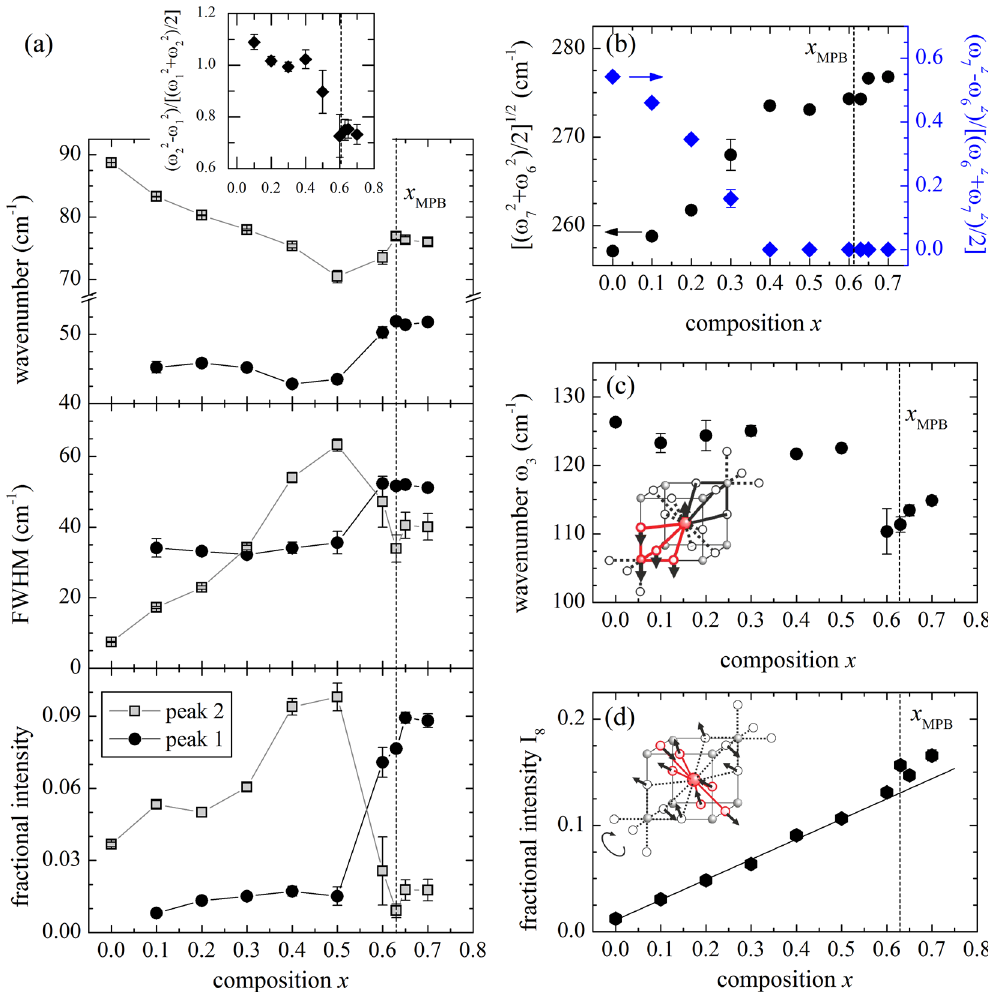
Figure 6. Composition dependence of ( a ) the phonon modes dominated by A-site cationic vibrations (peaks 1 and 2), ( b ) the average squared wavenumber and splitting of phonon modes dominated by B-site cationic vibrations (peaks 6 and 7), ( c ) the wavenumber of peak 3 generated by BO 3 vibrations against A-site cation vibrations (the inset represents the atomic vector displacements in the aristotype cubic structure), ( d ) the intensity of peak 8 corresponding to A-O stretching vibrations, which can also be thought as BO 6 tilting vibrations (the inset represents the atomic vector displacements in the prototype cubic structure). Peak numbering are as given in Fig. 5. The dashed lines mark the MPB. The solid lines in ( a ) are merely guides for the eye; the solid line in ( d ) is a linear fit to data points with x between 0 and